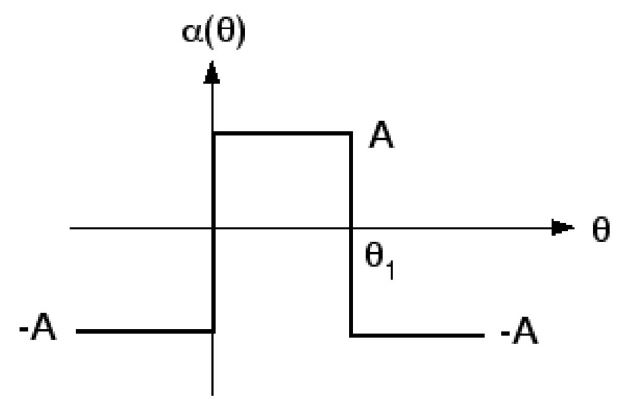
FIG. 1. Spin tune distance to resonance (cid:6) as a function of time (cid:4) jumping across the resonance